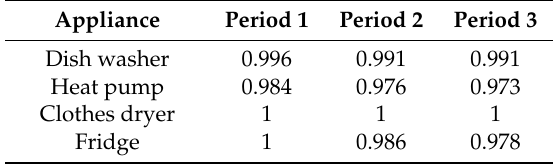
Table 3. F-score for four appliances from three periods. 263